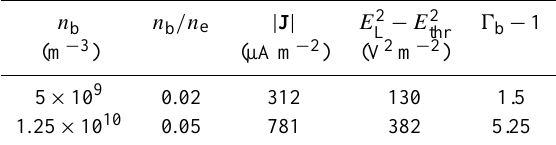
Table 6. Summary of electron beam density used in the